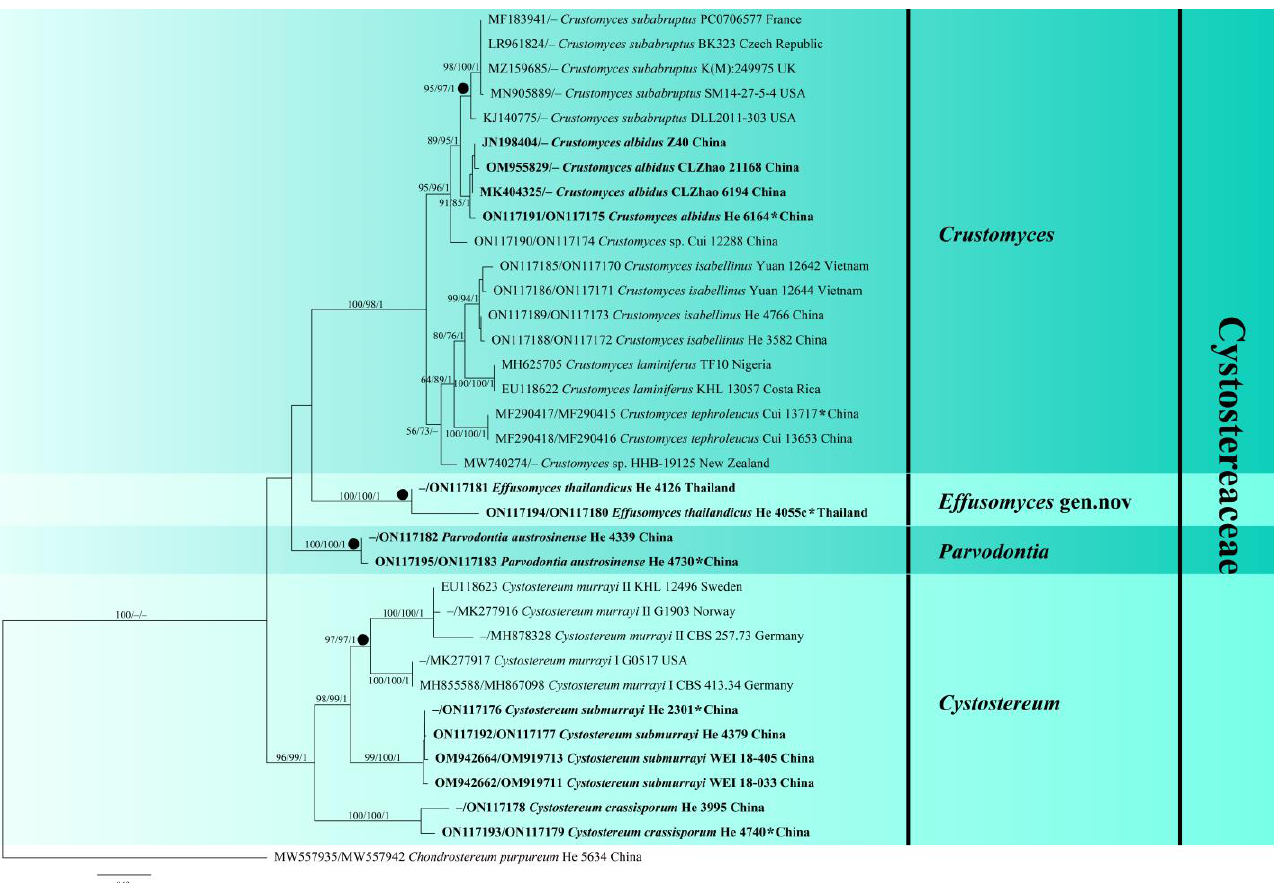
Figure 2. Phylogenetic tree of ML analysis from the concatenated ITS-LSU sequences of Cystostereaceae taxa. Branches are labeled with parsimony bootstrap values ( ≥ 50%, first), likelihood bootstrap values ( ≥ 50%, second), and Bayesian posterior probabilities ( ≥ 0.95, third). New species are set in bold; type species are marked with a solid circle ( ● ) in front of the branch, and holotypes of new taxa are marked with an asterisk (*).